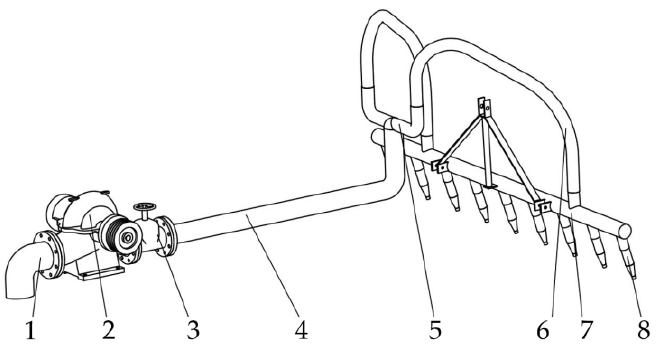
Figure 2. Structure of the hydraulic scouring system. 1. Inlet pipe 2. Single-stage double-suction centrifugal water pump 3. Flow control valve 4. Main transmission pipe 5. Reducing Tee 6. Metal braided corrugated pipe 7. Distribution pipe 8. Nozzle.